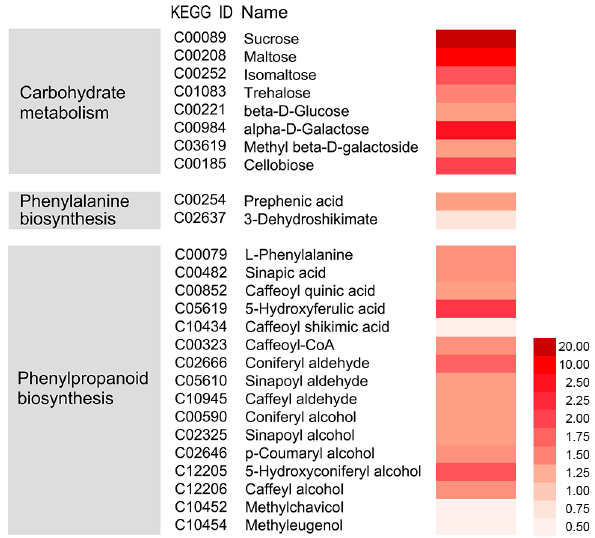
Figure 5. Effects of nano-CaCO 3 treatment on the metabolome of P. lactiflora inflorescence stems. Heat map of log2 relative levels of the main metabolites in nano-CaCO 3 /Control involved in carbohydrate metabolism, phenylalanine biosynthesis, and phenylpropanoid biosynthesis. The dark red and light red colors indicate increased and decreased metabolites, respectively.